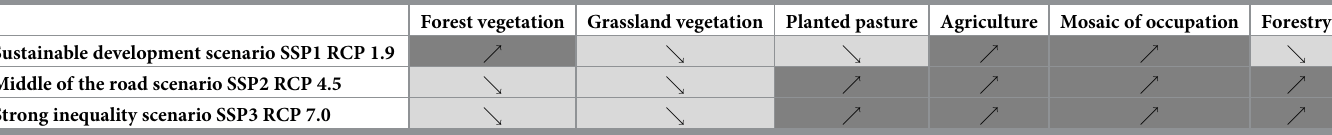
Table 6. The direction of change in land use and coverage, according to classes and scenarios between 2000 and 2050. % = Increase and & = Reduction. Forest vegetation Grassland vegetation Planted pasture Agriculture Mosaic of occupation Forestry Sustainable development scenario SSP1 RCP 1.9 Middle of the road scenario SSP2 RCP 4.5 Strong inequality scenario SSP3 RCP